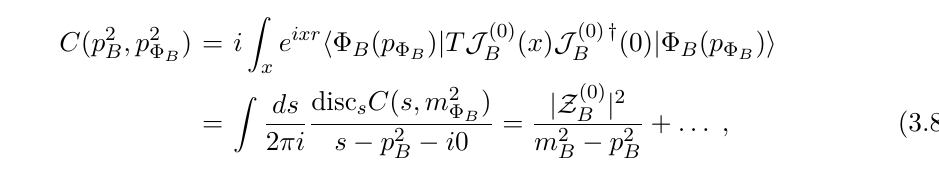
) (3.8), that is |Z (0) , p 2 B Φ B